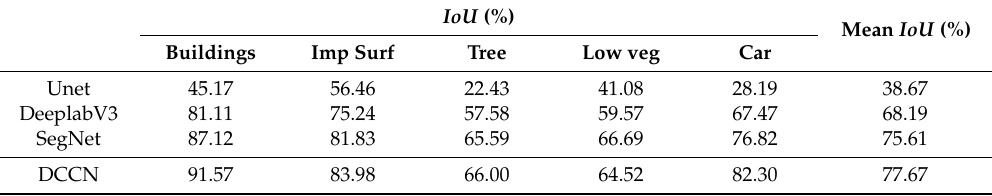
Table 4. IoU results between the proposed DCCN and several typical models.